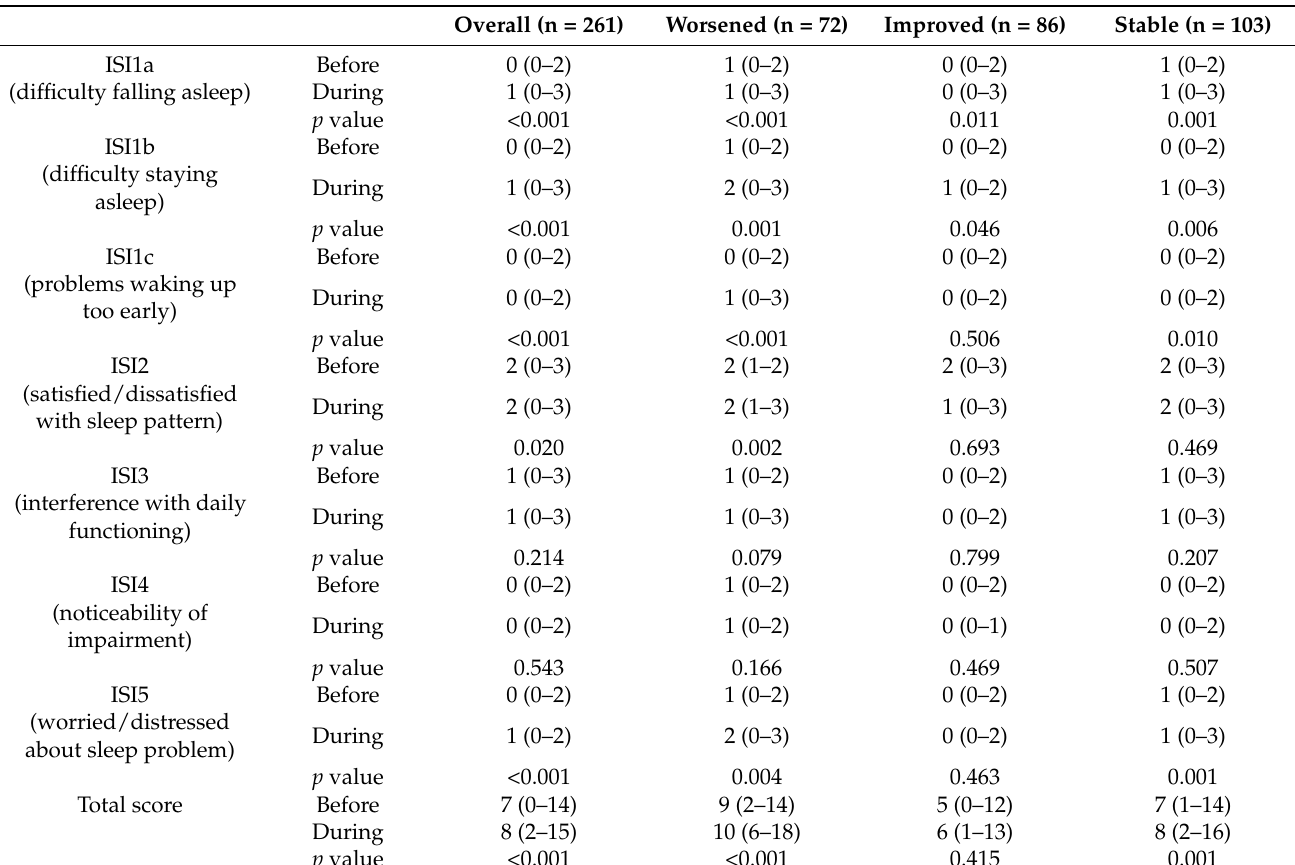
Table 2. Changes in mean Insomnia Severity Index (ISI) items and total score according to headache frequency change during social distancing. Numbers in parentheses indicate p values. Increasing scores mean worse